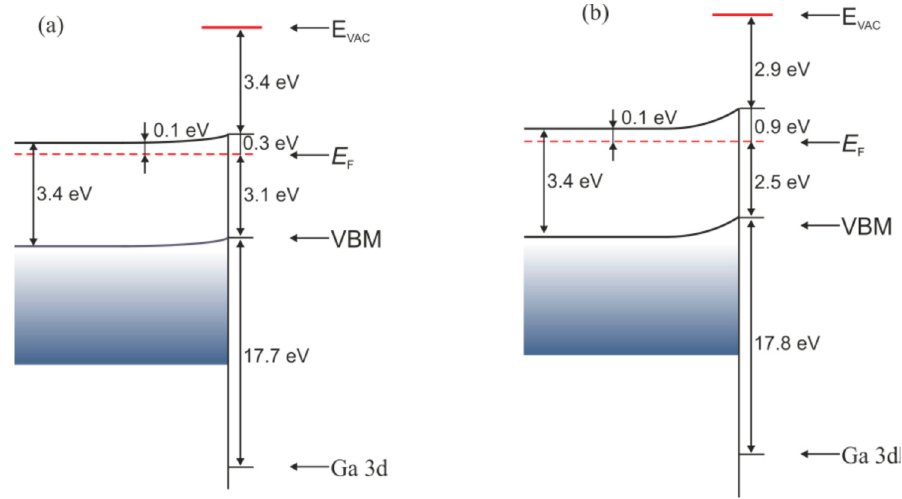
Figure 10. Energy band diagram for n ‐ GaN(0001) ( a ) before and ( b ) after bombardment with N ions. Reprinted with permission from [73]. Copyright Acta Phys. Pol. A.